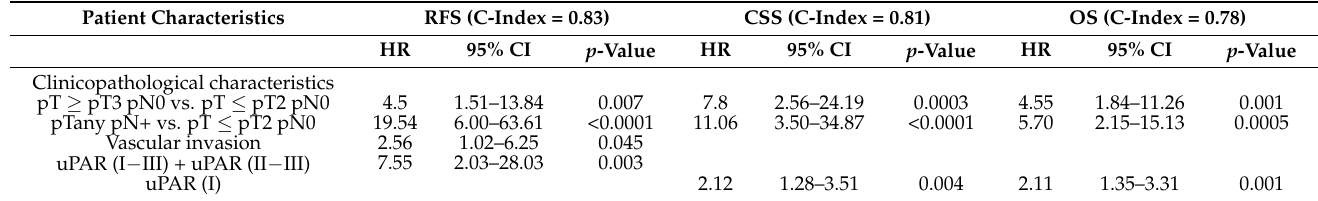
Table 4. Reduced multivariate